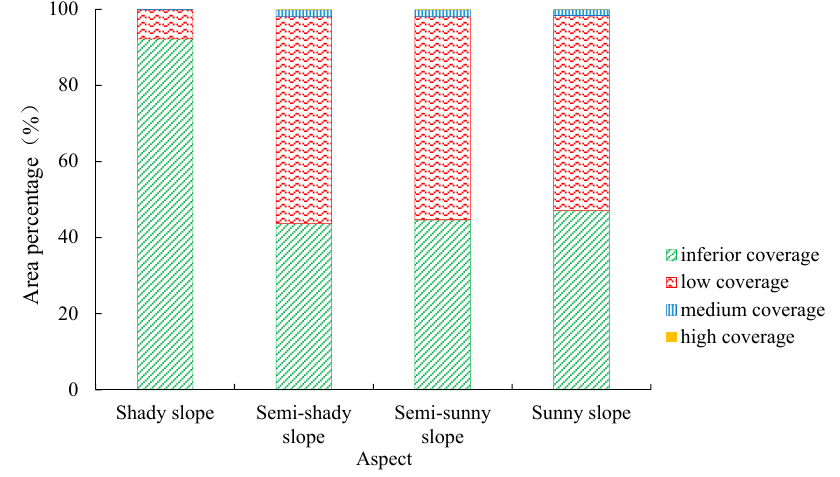
Figure 13. Area percentage of vegetation coverage in different aspects.